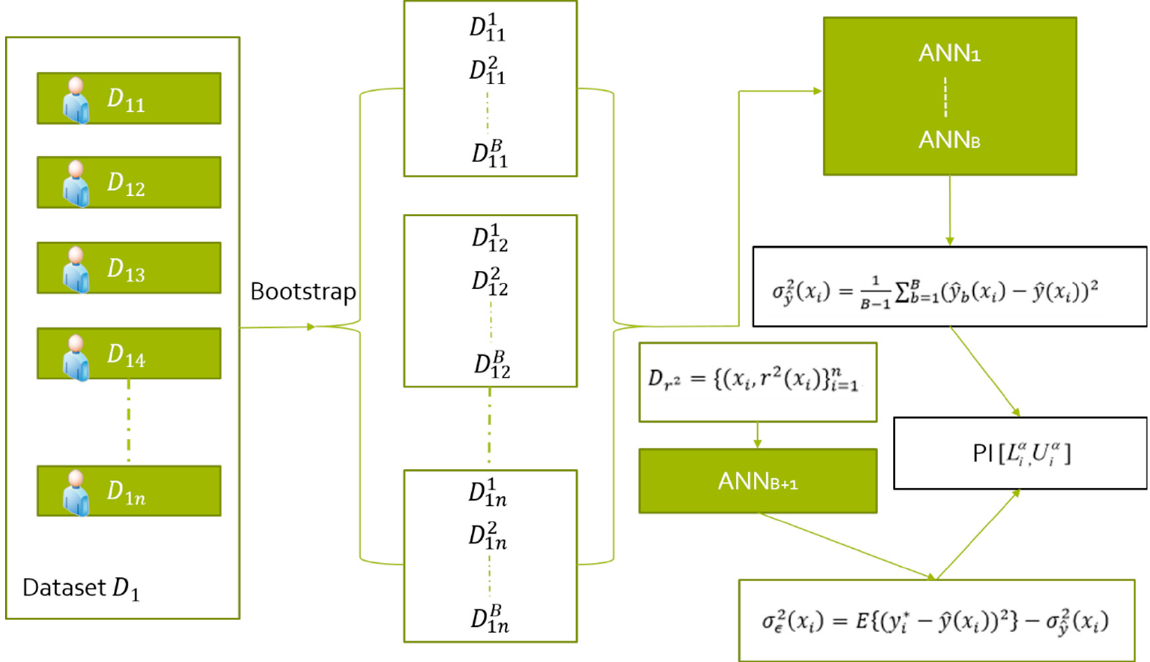
Figure 2. Model framework of bus personalized travel time PIs based on the bootstrap method.